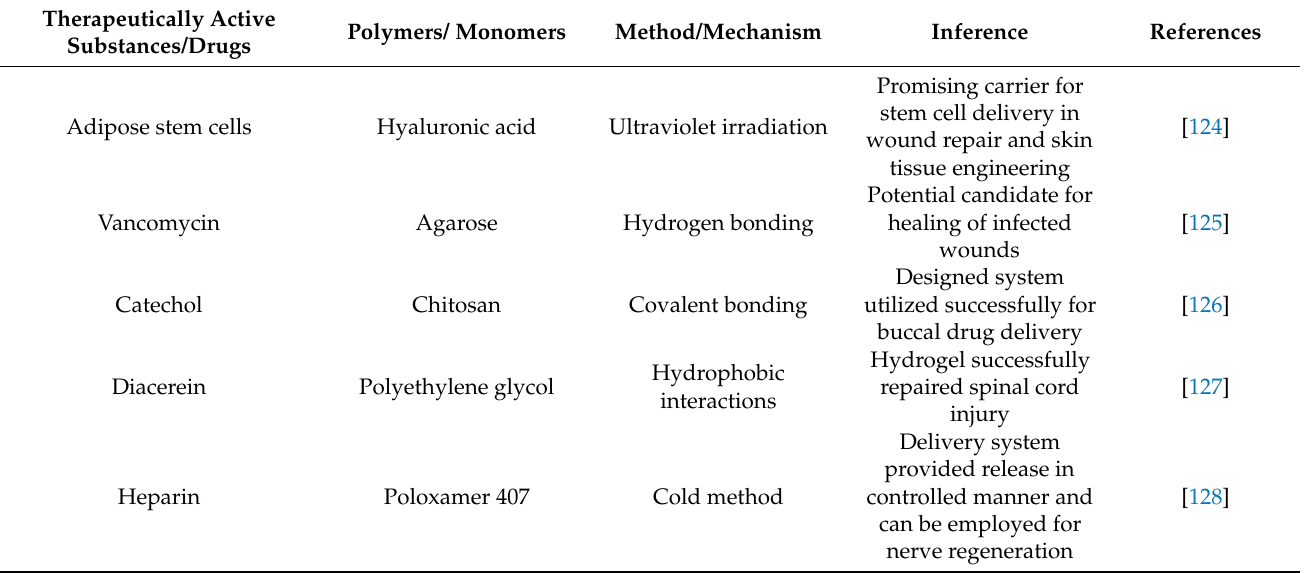
Table 1. Hydrogel loaded with various active